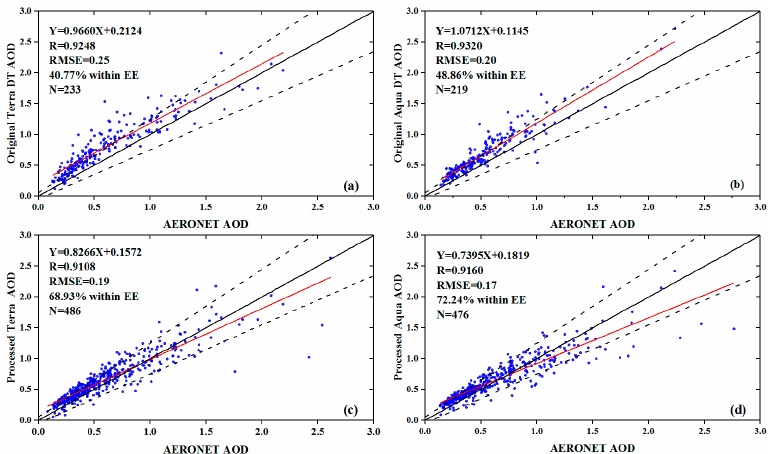
Figure 3. Comparison between AERONET AOD and original Terra/Aqua DT AOD and processed Terra/Aqua AOD data: (a) AERONET AOD vs. original Terra DT AOD; (b) AERONET AOD vs. original Aqua DT AOD; (c) AERONET AOD vs. processed Terra AOD; (d) AERONET AOD vs. processed Aqua AOD. The dashed, black, and red solid lines are the EE line, 1:1 line, and fitting line of linear regression respectively.